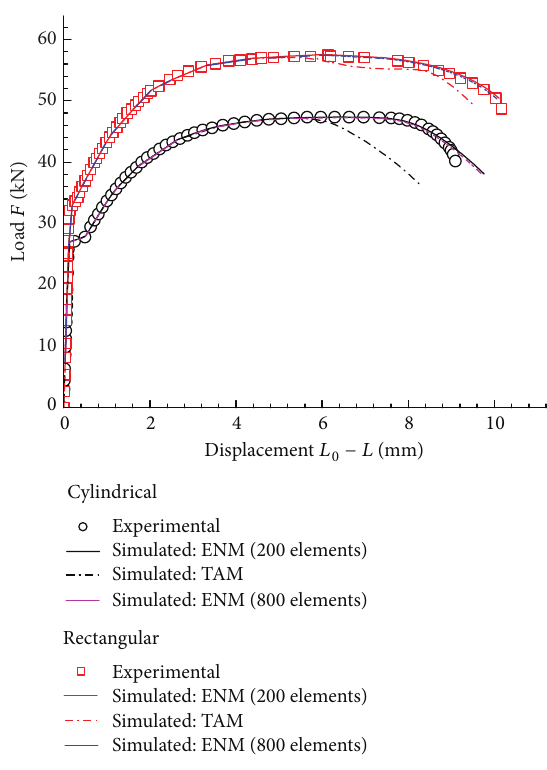
Figure 6: Experimental measured and computed 𝐹 - Δ𝐿